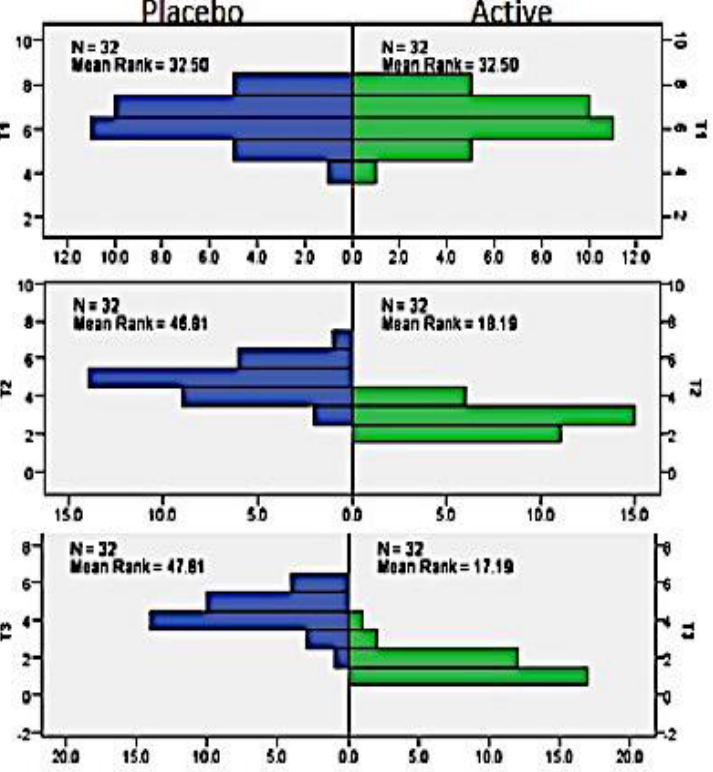
Figure 1. Mean rank of PP in active vs. placebo group in T1, T2, and T3.